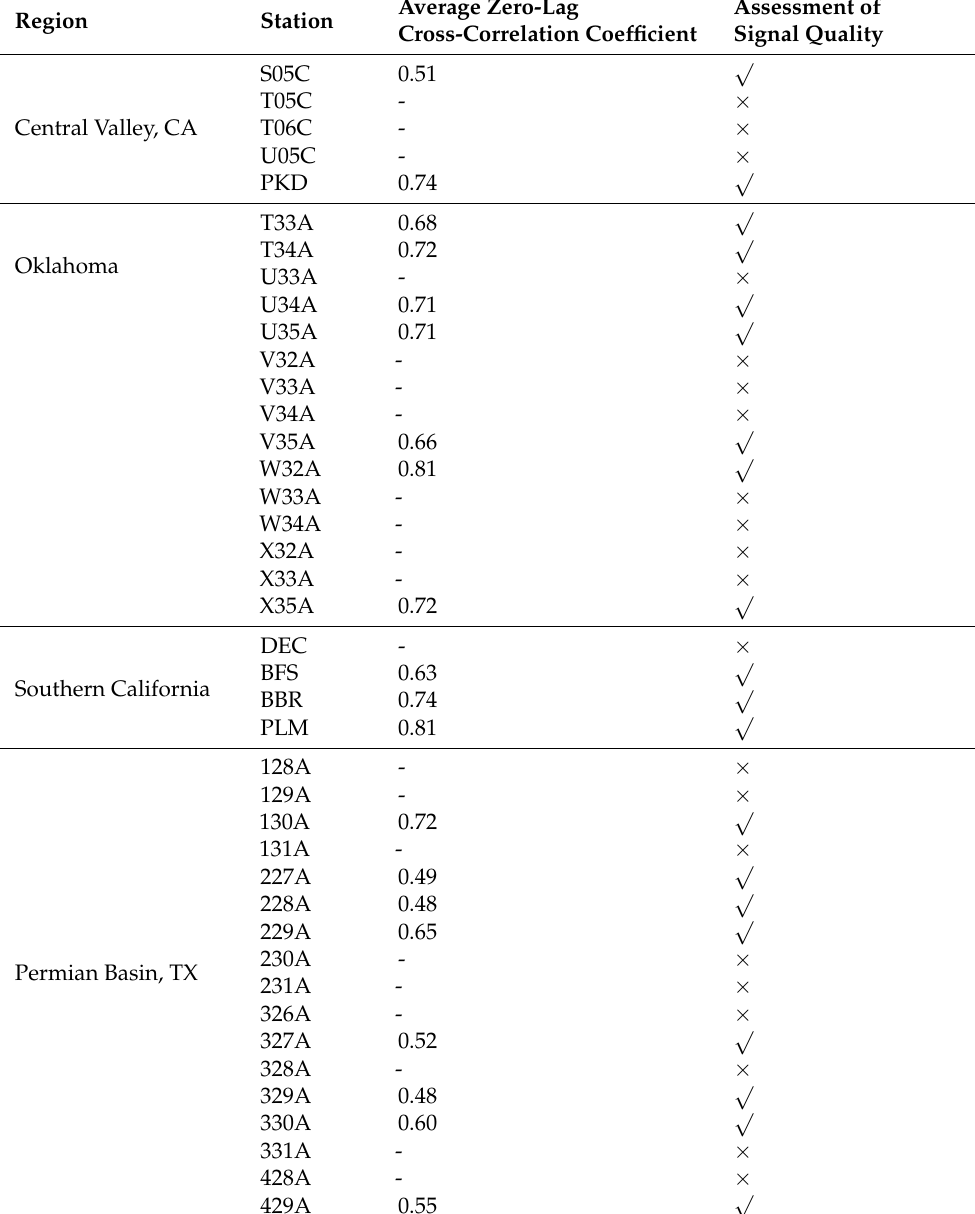
Table 3. The qualitative signal-to-noise ratio and zero-lag cross-correlation coefficient for each station used in this study. The × marks indicate stations with insufficient signal